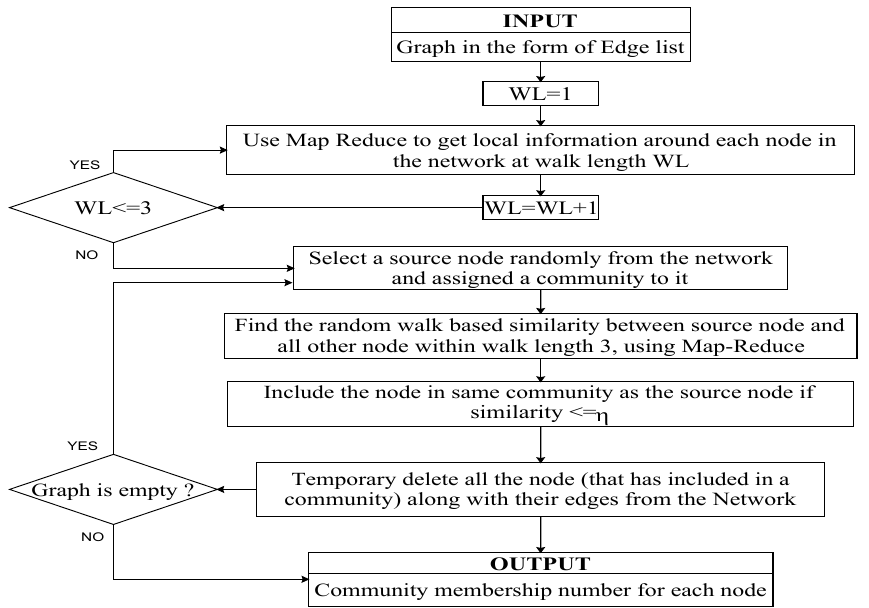
Figure 1. Execution flow for community detection using small world phenomenon. Algorithm 1: Community detection using small world phenomenon (CDSW). Mapper (Source Node, Community Membership, Graph